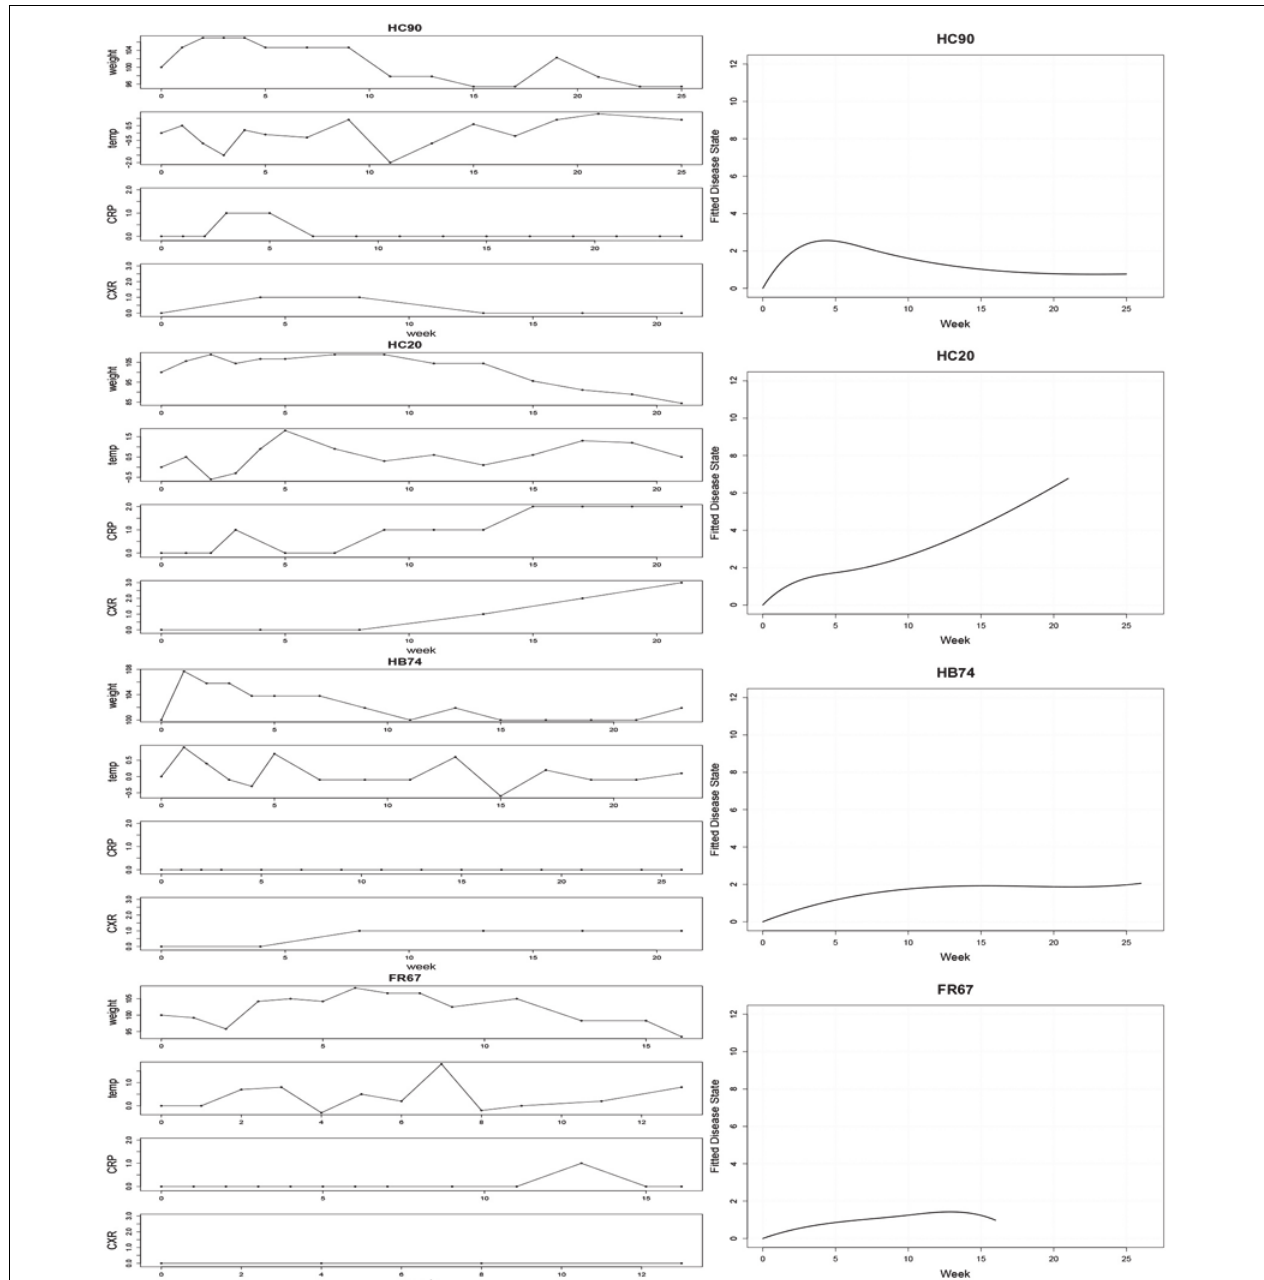
FIGURE 2 | Left: Observed clinical variables for four typical subjects: HC90, HC20, HB74, FR67. CRP values are binned into 3 groups, corresponding to absent, low, or high CRP levels. Right: Estimated disease trajectories from Bayesian hierarchical B-Spline models incorporating the four clinical covariates.